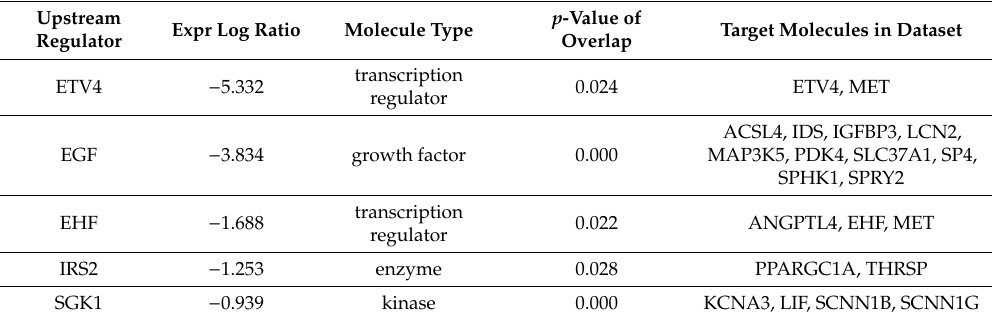
Table 1. Upstream regulators from the Ingenuity Pathway Analysis (IPA) when comparing the urea and control groups.